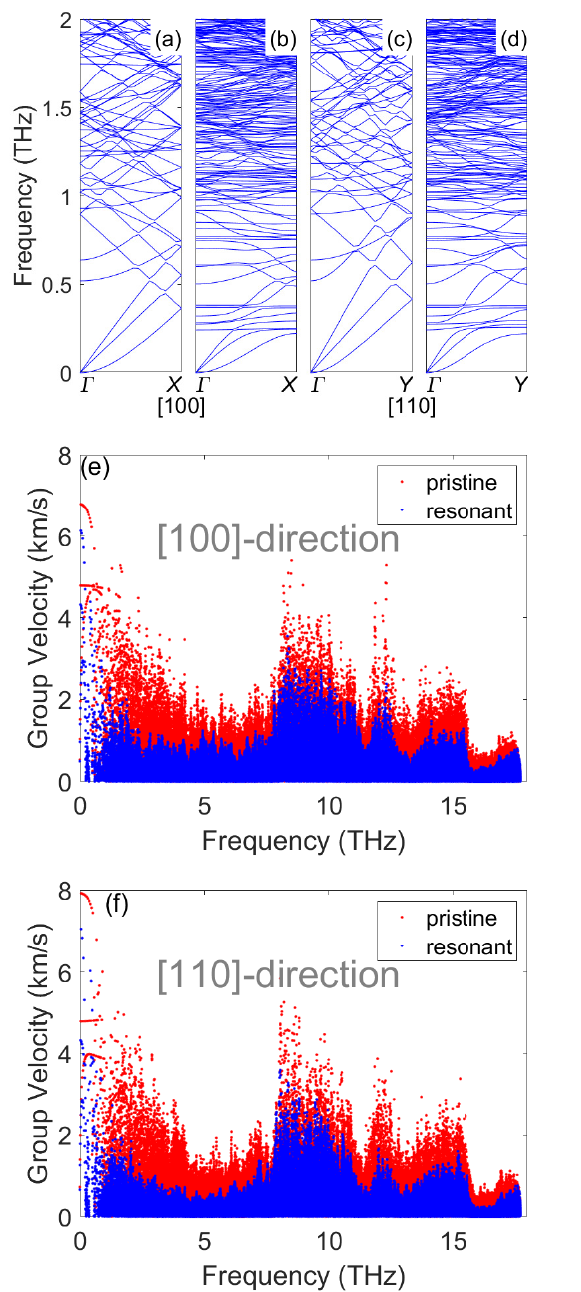
Figure 3. Phonon dispersion of ( a ) pristine membrane along the [100]-direction, ( b ) resonant mem- brane along the [100]-direction, ( c ) pristine membrane along the [110]-direction and ( d ) resonant membrane along the [110]-direction. Phonon group velocities of the pristine and resonant membranes: ( e ) along the [100]-direction and ( f ) along the